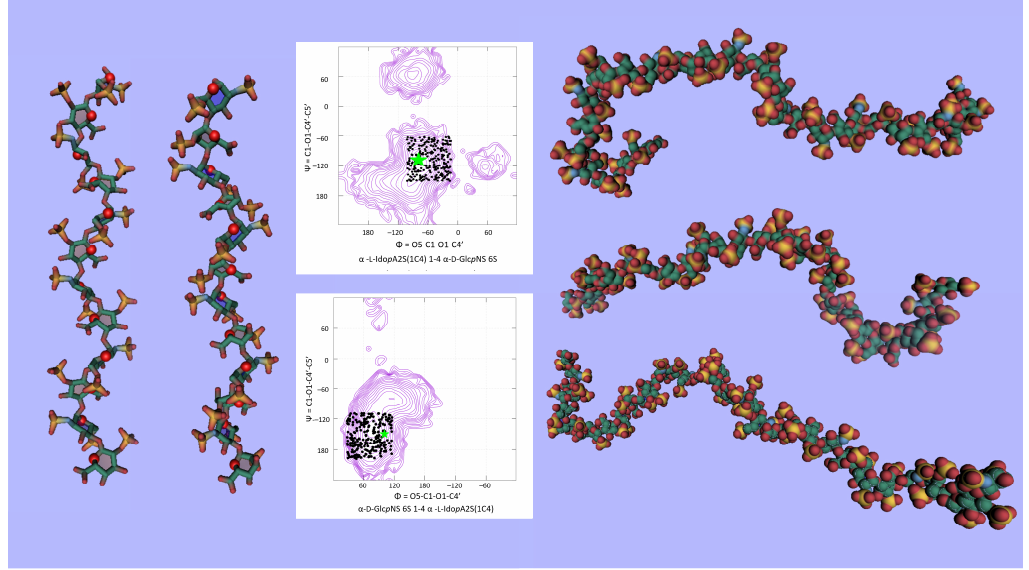
Figure 9. 3D representation of heparin in a helical conformation (left panel) and in disordered conformation. The distribution of the Φ and Ψ angles are reported on the two corresponding potential energy surfaces (drawn with SweetUnityMol [82]).